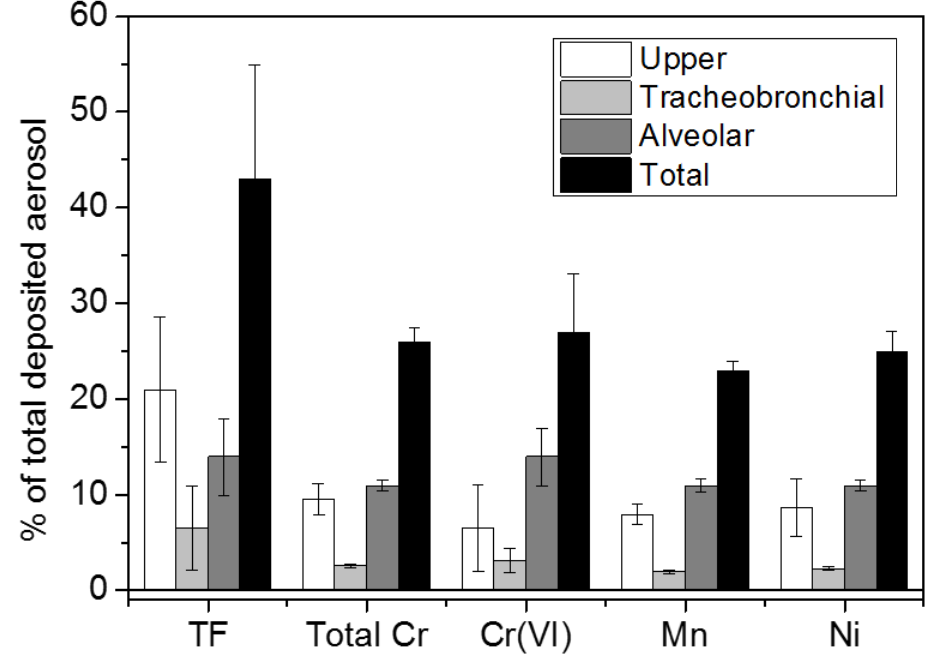
Figure 2. Percentage of total deposited aerosol of metal particles arising from stainless steel welding based on aerodynamic diameter (calculated by particle optical diameter, dynamic shape factor, and density). Adapted by Cena et al [14]. TF: total fume; Cr: chromium; Cr VI: hexavalent chromium; Mn: manganese; Ni: Nickel. For mild steel, percentage of total deposited aerosol are for TF 12, 6.3, 17, and 38 and for Mn 7.8, 2.0, 11, and 23, respectively, in upper, tracheobronchial, alveolar, and total regions.